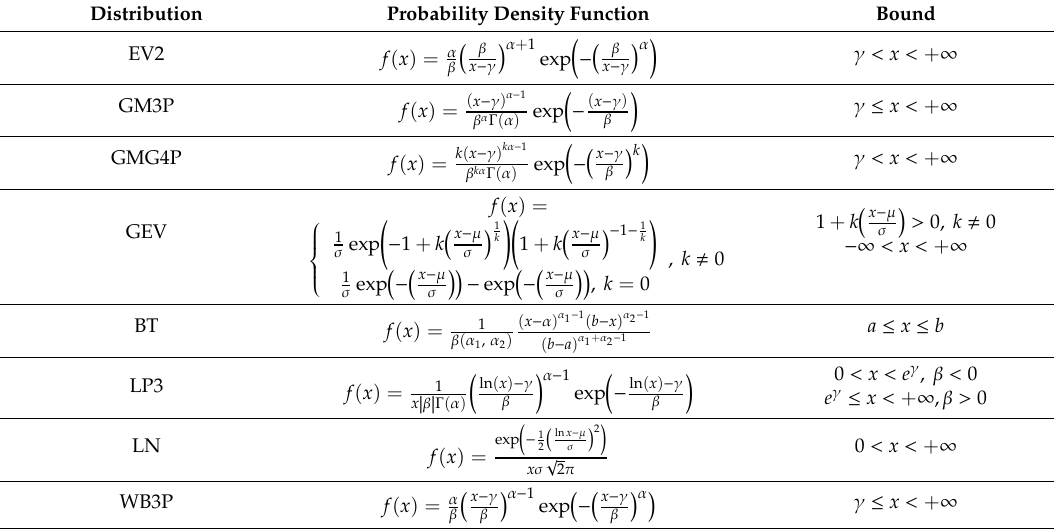
Table 2. The probability distribution functions used for this